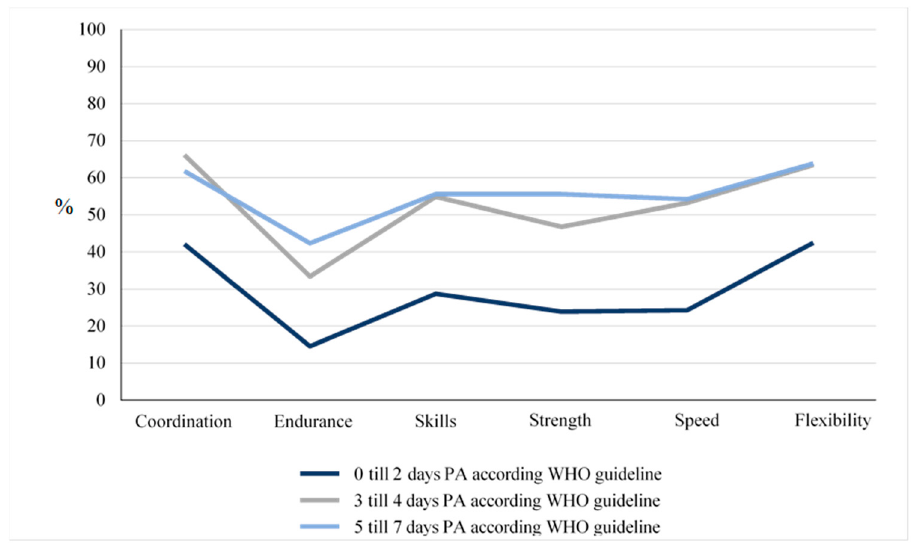
Figure 4. Relationship between a positive self-concept and physical activity in the CHD group. There is a clear relationship between a positive physical self-description (%) of basic functions of physical performance and the level of PA reported in days per week (Figure 4 and Table 6). The percentage of patients reporting a positive self-description is significantly higher for those who are physically active on more than two days per week. Table 6. Correlation of a positive self-concept with overall activity (per CHD group).